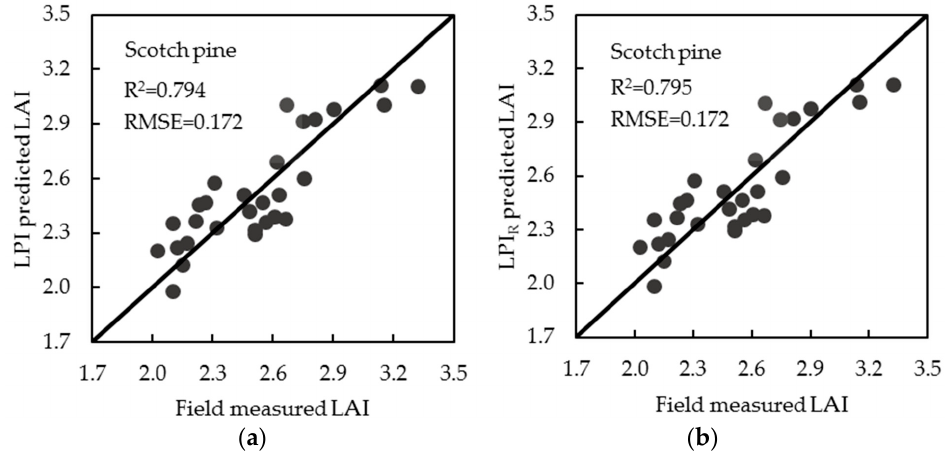
Figure 4. The 1:1 relationship between the field-measured LAI and LiDAR-predicted LAI for Scotch pine forests based on: ( a ) the raw intensity data (i.e., LPI); ( b ) the range-normalised intensity data (i.e., LPI R ). R 2 and RMSE are values from leave-one-out cross-validation.